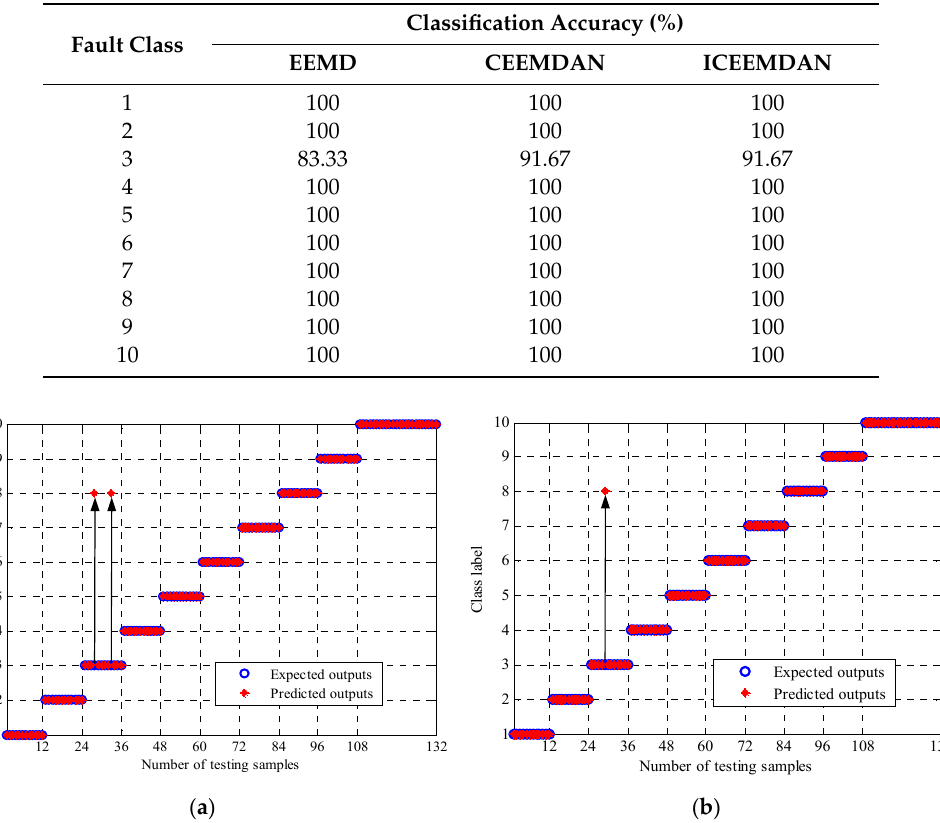
Table 4. The bearing fault diagnosis results by the three preprocessing algorithms.